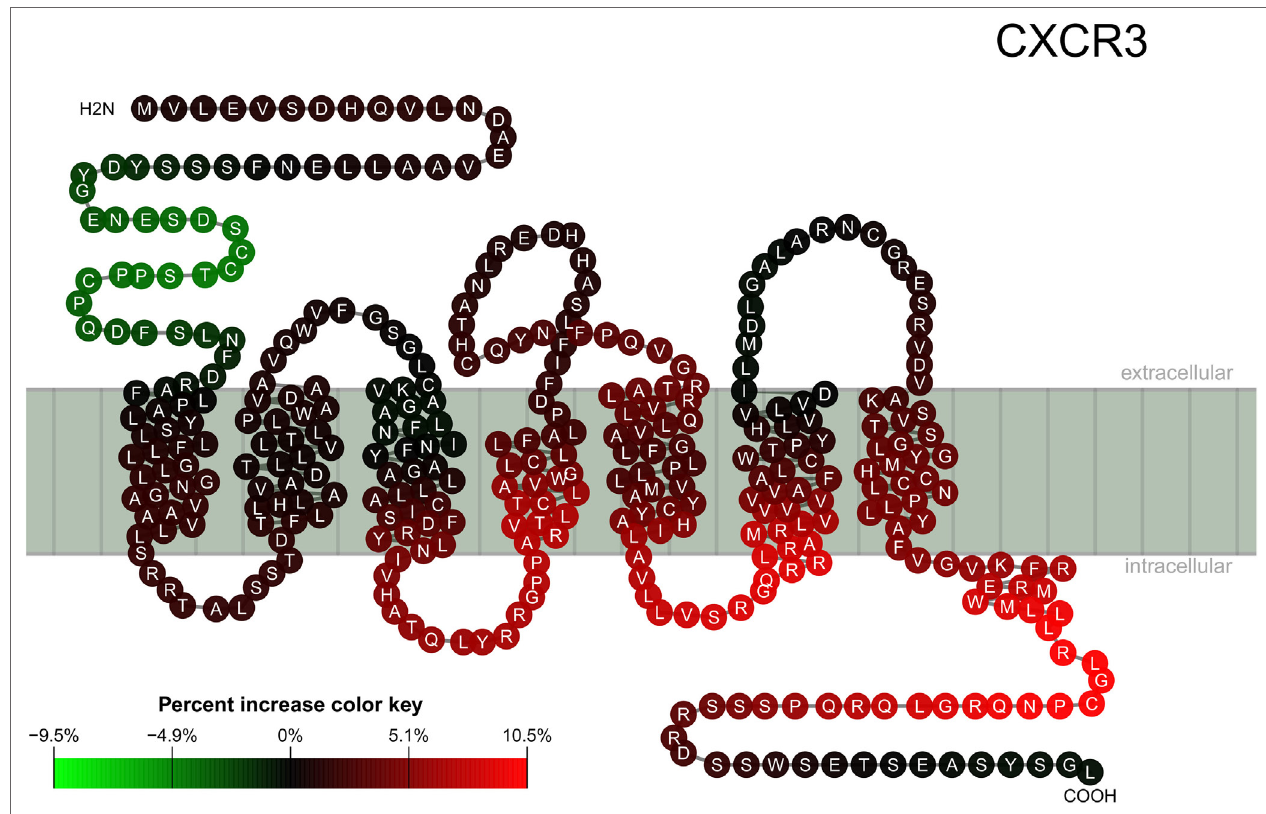
FigUre 2 | Location of epitopes on the CXCR3 structure. Mapping of binding signal (compare Figure 1 ) of SSc patient sera to a serpentine model of CXCR3. Each pearl represents a single amino acid residue, the letter inside each pearl the amino acid in 1-letter code. The color of each pearl indicates the percent increase value of the SSc specific binding signal associated with the respective amino acid residue (color